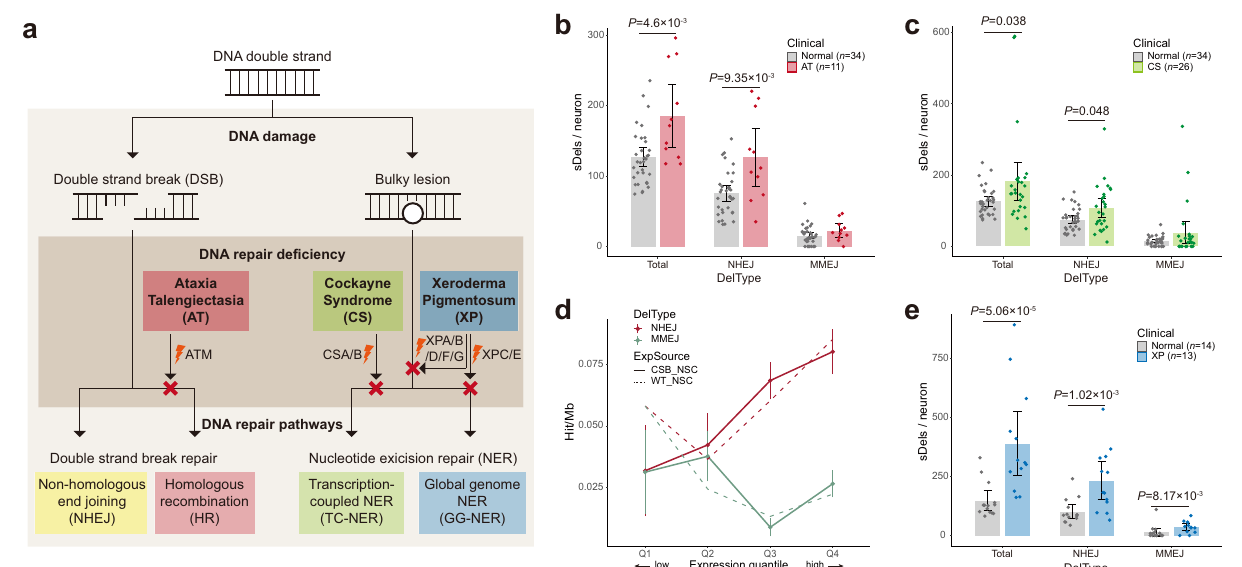
Fig. 4 | Increased burden and distinctive patterns of somatic deletions in neurons of individuals with DNA repair de fi ciencies. a Three DNA repair- defective diseases (AT,CS, XP)and theircorresponding defective repair pathways. b , c , e Total and NHEJ- and MMEJ-based deletion burdens in AT ( b ), CS ( c ), and XP ( e )singleneuronscomparedtoage-matchedcontrols. n ,numberofsingleneurons; bar graph, mean±95% CI; two-sided Mann – Whitney U test. d Distinctive